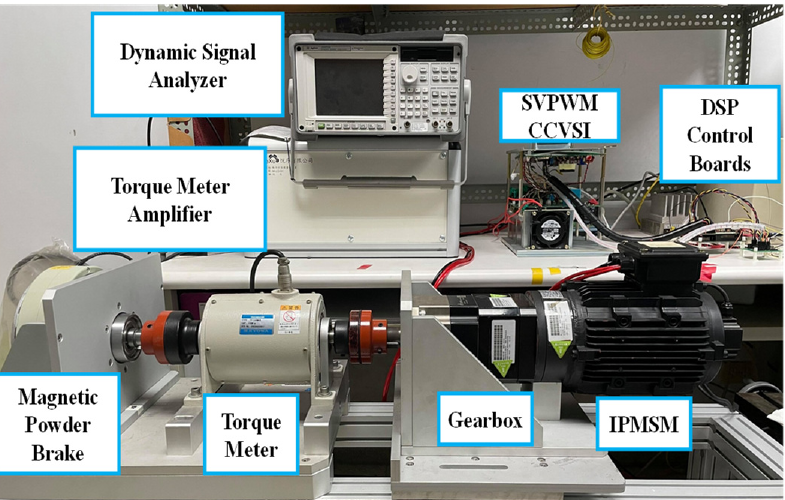
Figure 7. Photo of experimental setup. Table 1. Parameters of magnetic powder